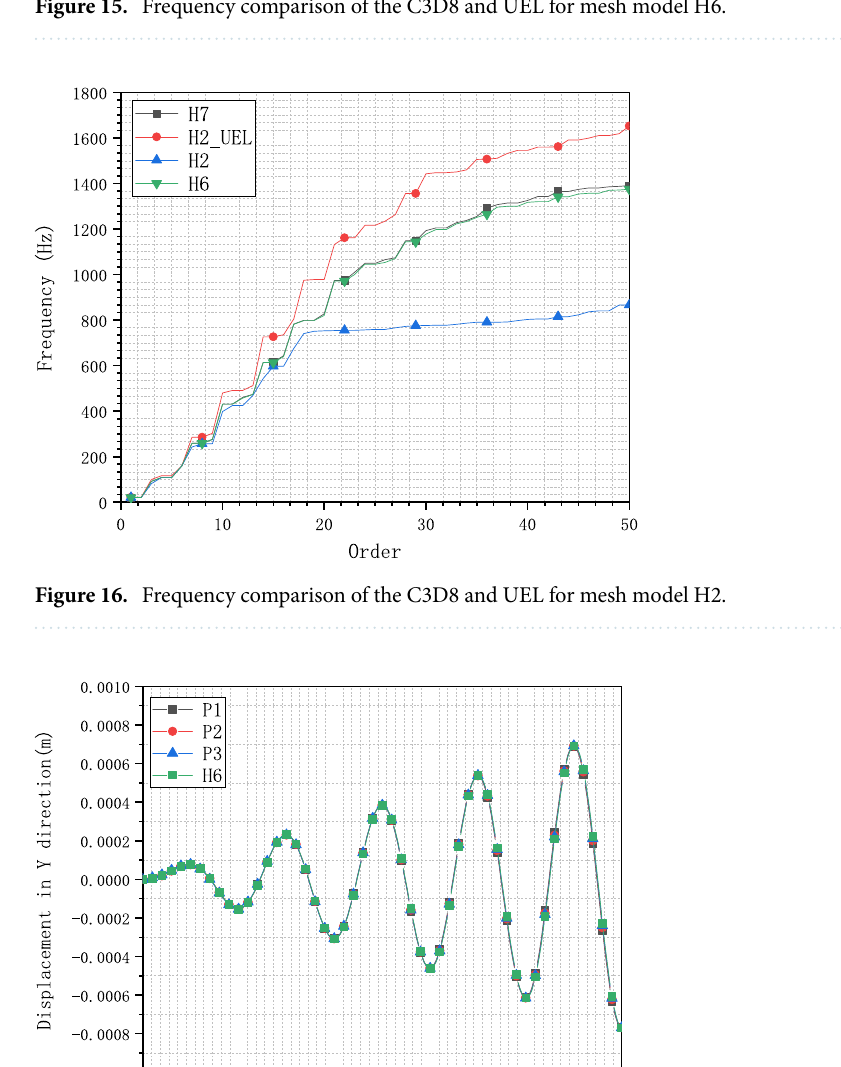
Figure 15. Frequency comparison of the C3D8 and UEL for mesh model H6.